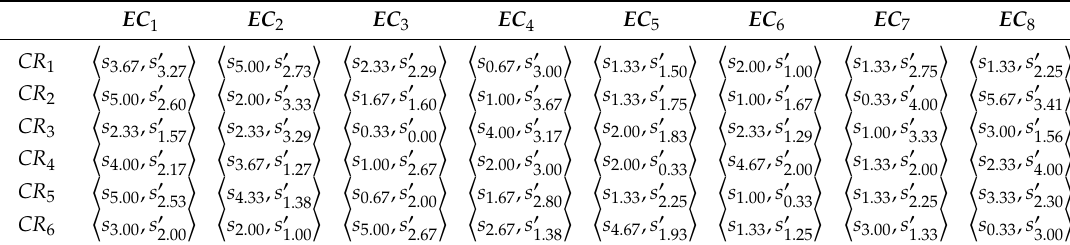
Table 4. The positive ideal assessment.